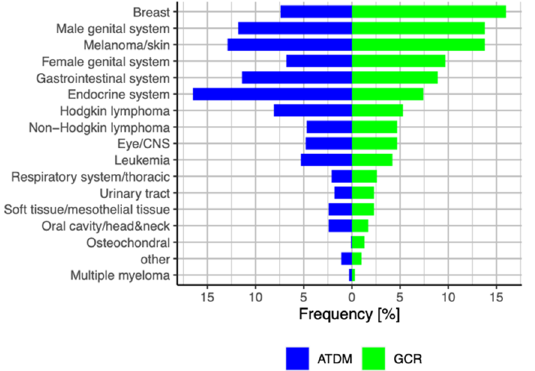
Figure 4. Distribution of cancer types in AYA cancer patients from the Augsburg Tumor Data Management (ATDM) and the Centre for Cancer Registry (GCR) of the Robert-Koch-Institute (RKI), Germany.